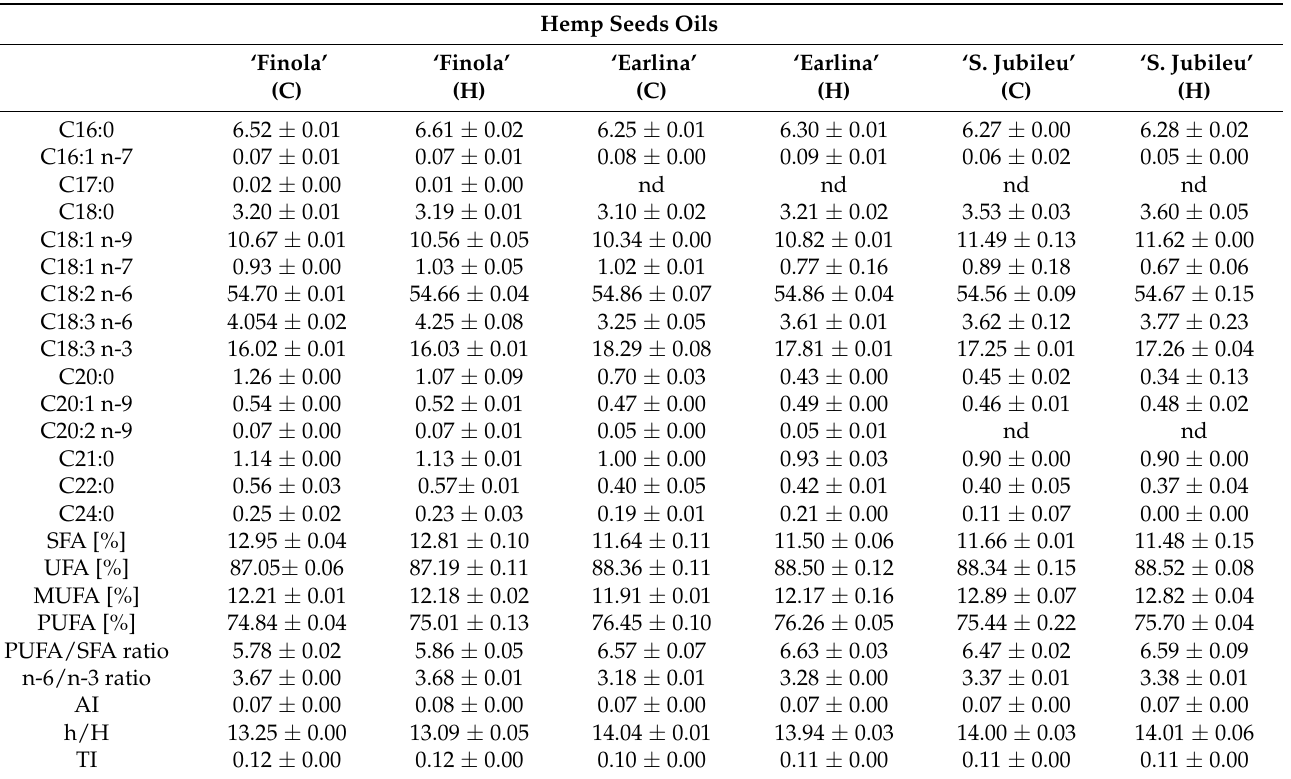
Table 2. Fatty acid profiles [%] and lipid quality indicators in oils obtained from different hemp varieties